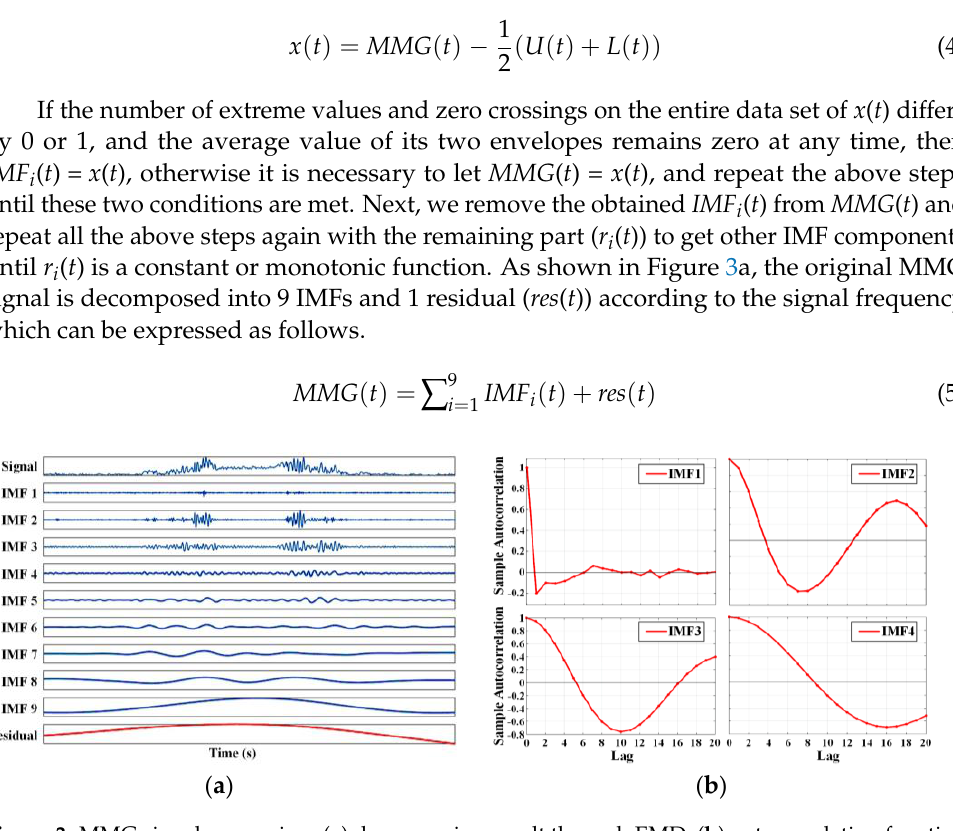
Figure 3. MMG signal processing: ( a ) decomposing result through EMD; ( b ) autocorrelation function curves of the first four IMFs.